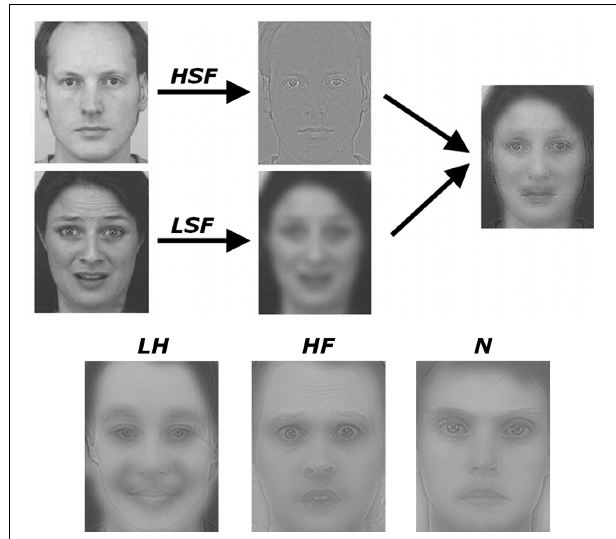
FIGURE 2 | Schematic representation of how the hybrid stimuli were created. Male and female faces were selected from a validated database and subjected to spatial frequency filtering. Hybrid faces were then created by overlaying a high-spatial frequency (HSF) face with a low-spatial frequency (LSF) face of opposite gender. Emotional expressions (in either the HSF or LSF face) were always overlaid with a neutral facial expression of opposite gender and opposite filtering. Three stimuli examples are also displayed on the lower part of the Figure. A HSF neutral face overlaid with a happy LSF face (condition LH), a HSF fearful face overlaid with a neutral LSF face (condition HF) and a control condition containing neutral faces in both HSF and LSF bands (N). Full details in the text.